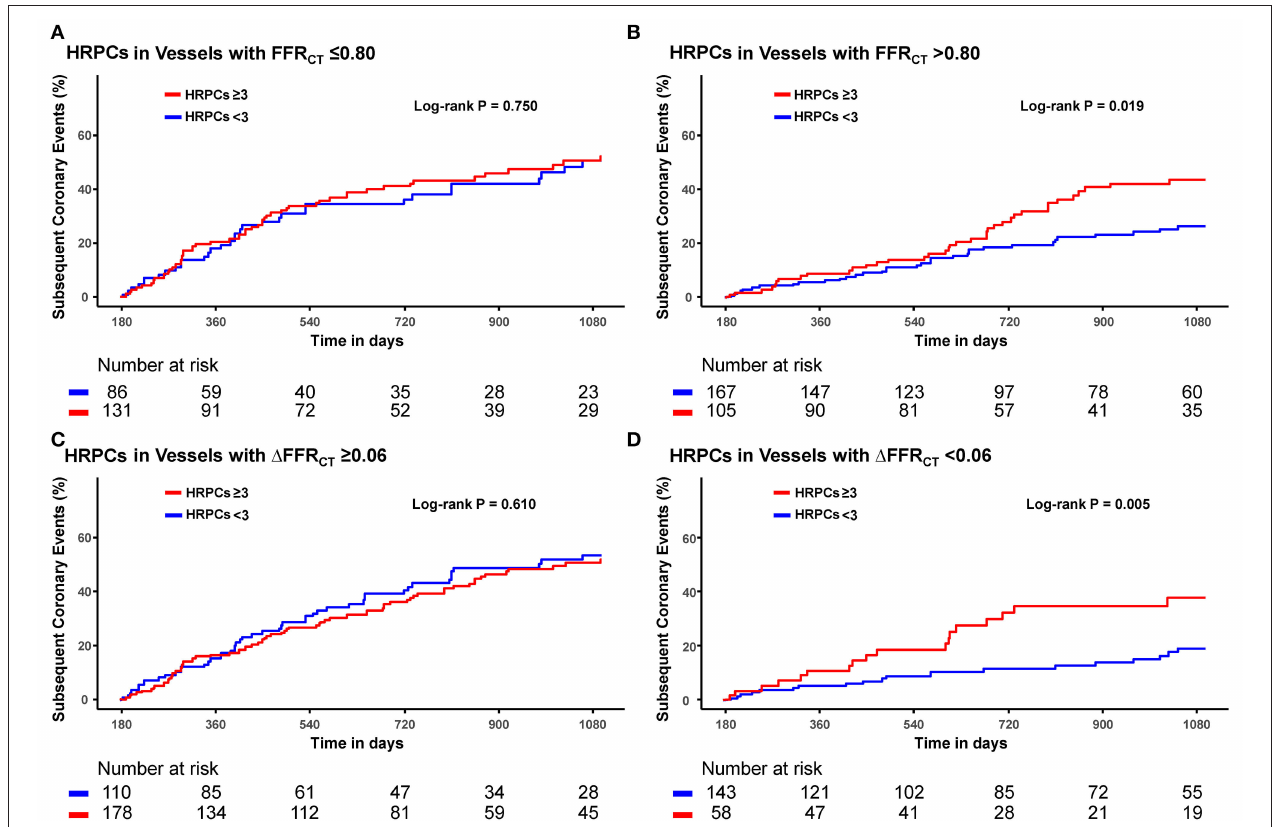
FIGURE 5 | Differential prognostic impact of HRPCs for subsequent coronary events according to hemodynamic parameters. Differential prognostic impact of number of HRPCs of ≥ 3 is evaluated in vessels with (A) FFR CT ≤ 0.80, (B) FFR CT > 0.80 (C) 1 FFR CT ≥ 0.06, and (D) 1 FFR CT < 0.06. Abbreviations: FFR CT , fractional flow reserve by coronary computed tomography angiography; HRPCs, high-risk plaque